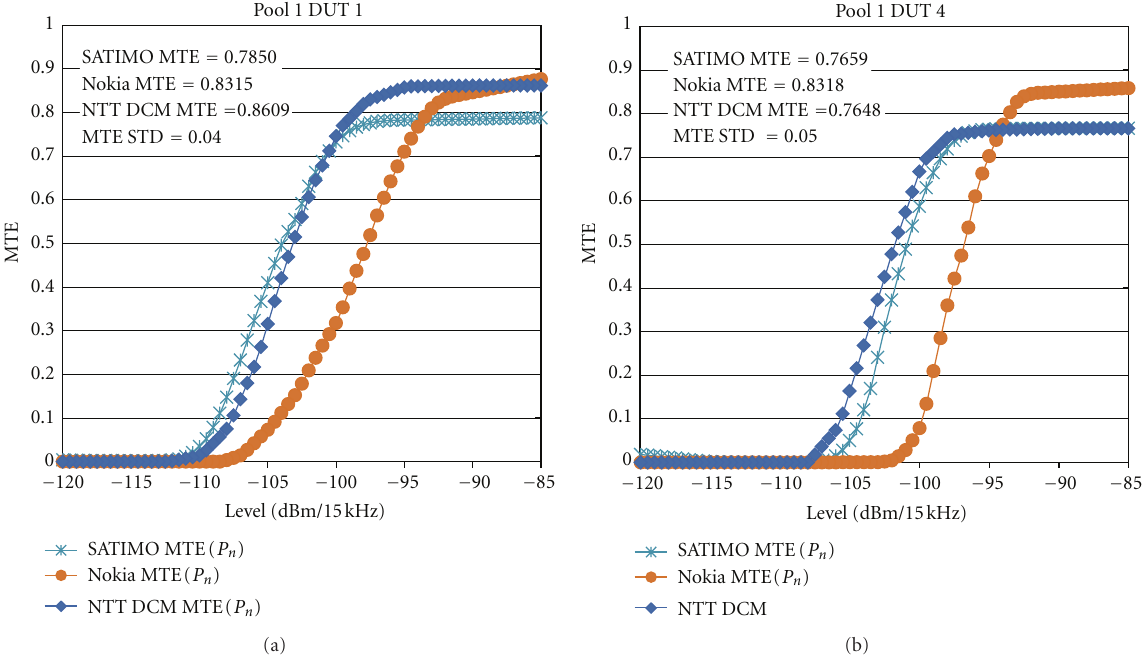
Figure 7: MTE for Pool 1 with the AC